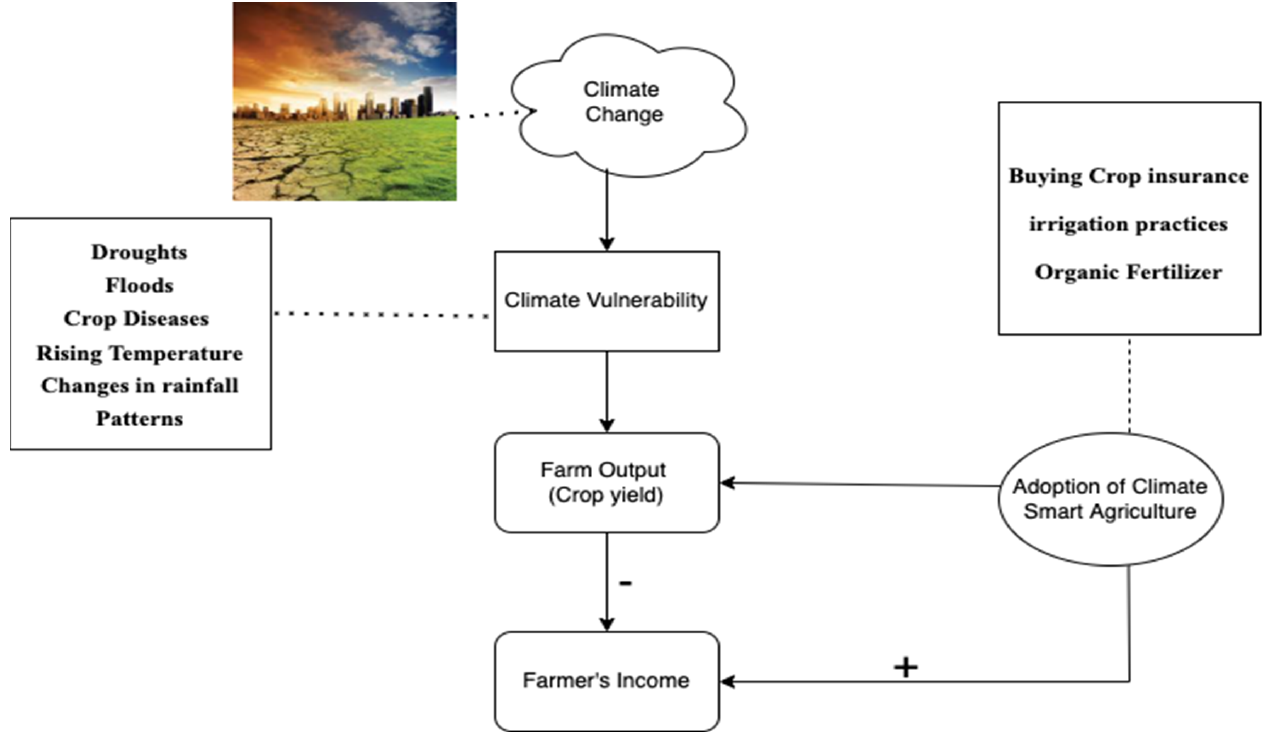
Figure 1. Conceptual framework on climate change, its repercussions, climate-smart agriculture practices and farmers’ income.